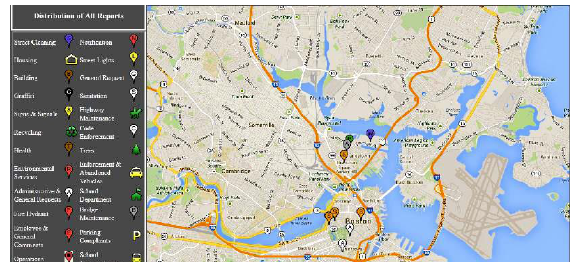
Figure 5. Cartographic capability of the system to represent recorded